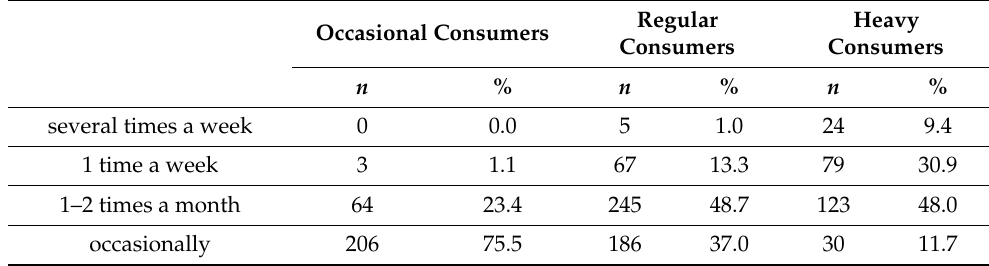
Table 3. Frequency of edible mushrooms consumption in individual segments of edible mush- rooms